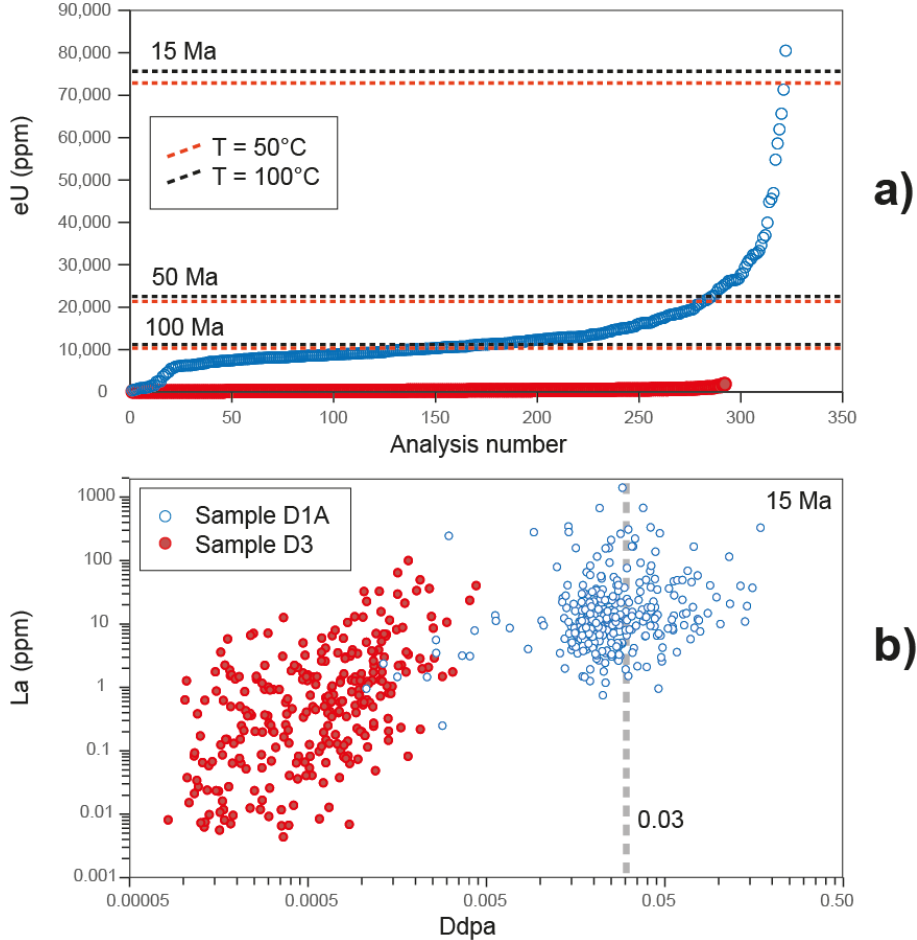
Figure 12. ( a ) Binary diagram showing the eU parameter (age-corrected initial U content of zircon), calculated using the equation reported by Loucks et al. [54] and an age of 2690 Ma, for zircon grains of samples D1A and D3 displayed in order of increasing U content. The dashed lines represent results of calculations performed using Equation (5) of Meldrum et al. [64], and which calculates the minimum eU required for complete metamictization of zircon maintained at constant temperature (50 °C and 100 °C) for a defined time interval (here, the time intervals 15 My, 50 My, and 100 My are shown). ( b ) Binary diagram showing zircon D dpa vs. La (ppm), with the D parameter calculated for a 15 My time interval and using the equations reported by Gao et al. [65].